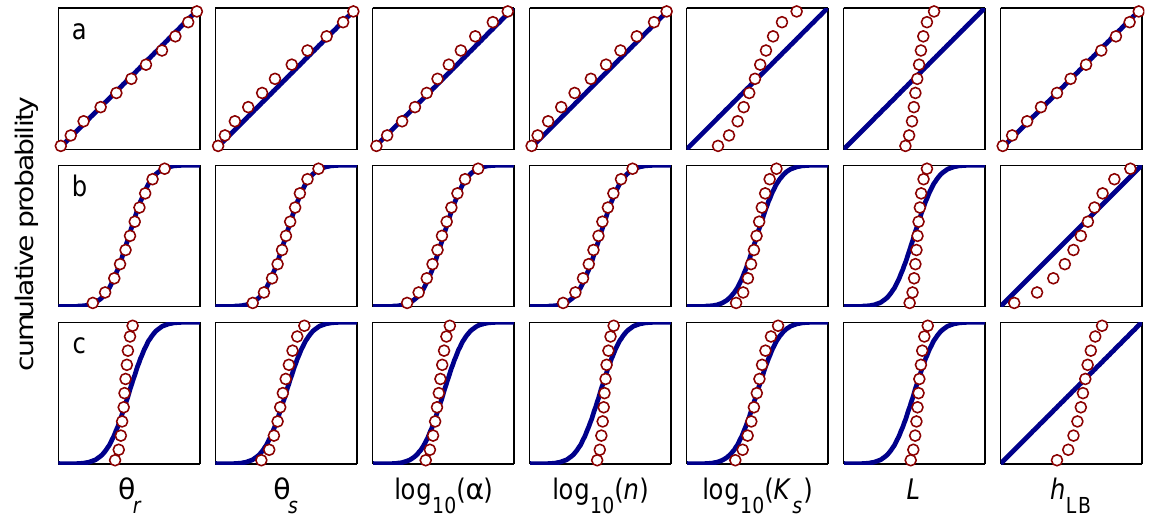
Fig. 6. Cumulative prior and posterior probability distributions using real soil water content data and three different prior probability distributions: (a) multivariate uniform distribution (Prior 1), (b) multivariate normal distribution without correlation among the soil hydraulic parameters (Prior 2), and (c) multivariate normal distribution with correlation among the soil hydraulic parameters (Prior 3). The blue lines represent the prior distributions. The red circles denote the 2.5, 10, 20, 30, 40, 50, 60, 70, 80, 90, and 97.5% quantiles of the posterior distributions, respectively. The x-axes cover the bounds listed in Table